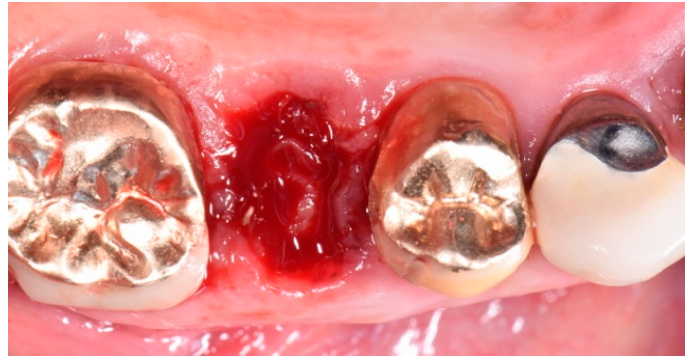
Figure 5. Insertion of the first layer of PRF membrane inside the post-extraction socket.